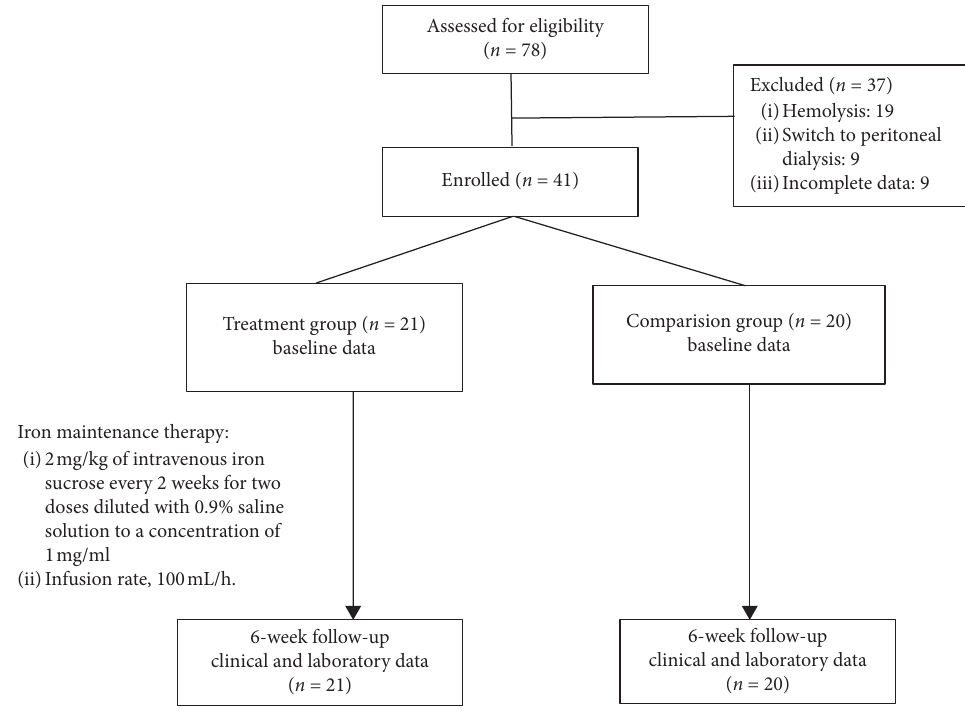
Figure 1: Patient flowchart.